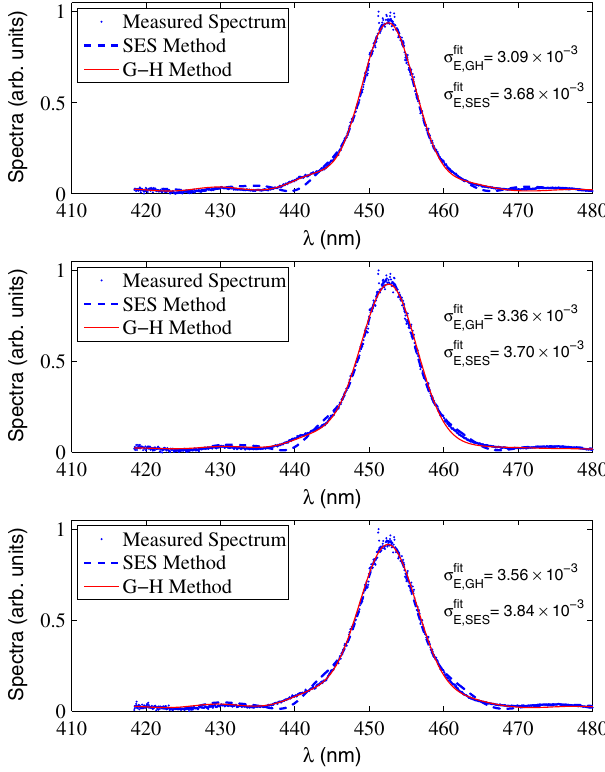
FIG. 16. (Color) Measured optical klystron spectra with an in- creased energy spread and a low buncher setting N electron beam energy is 400 MeV and the single-bunch beam current is about 15 mA. Compared to Fig. 14, the FEL interac- tion is increased to produce a larger energy spread. Both the G-H method and the SES method are used to fit the measured spectra. The fitted values of the energy spread using both methods are listed in the plot. In each subplot, the background of the measured spectrum has been subtracted.